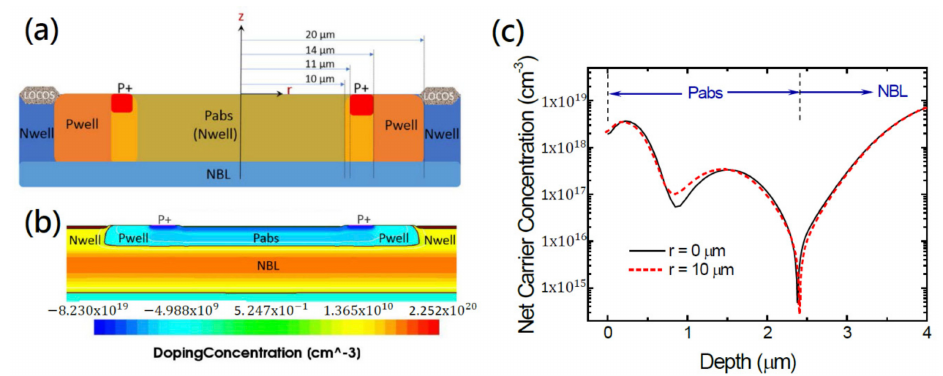
Figure 1. ( a ) Schematic cross-sectional device structure. The SPAD active region is 20 µ m in diameter. The distance from the device center is denoted as r . Note that there is a 4- µ m overlap region between the Pabs and Pwell layers. ( b ) Simulated 2-D doping profile. ( c ) z -direction 1-D net doping concentration profiles taken at r = 0 µ m (black solid line) and r = 10 µ m (red dashed line).